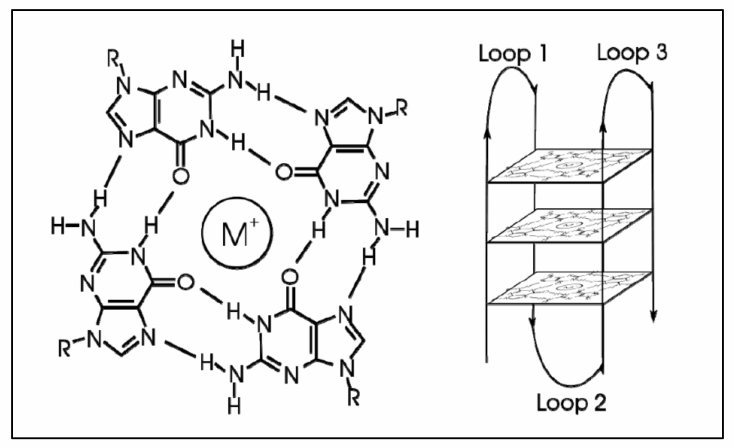
Figure 4. G-Quadraplex. A tetrad forms with the addition of an ion (left), while multiple tetrads form the quadraplex (https://en.wikipedia.org/wiki/G-quadruplex#cite_note-ReferenceC-4, accessed on 20 June 2021).